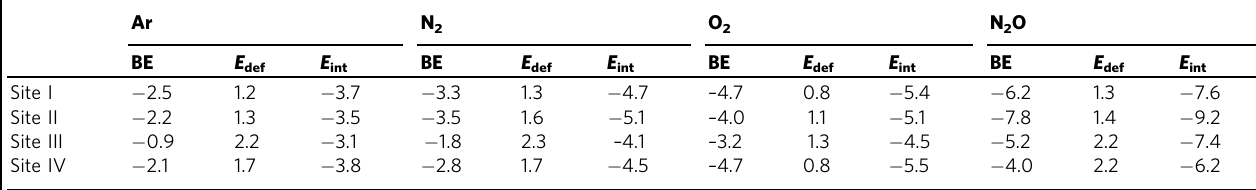
Table 1 The obtained binding energy (BE), deformation energy (E def ), and interaction energy (E int ) from the calculations. Ar N 2 O 2 N 2 O BE E def E